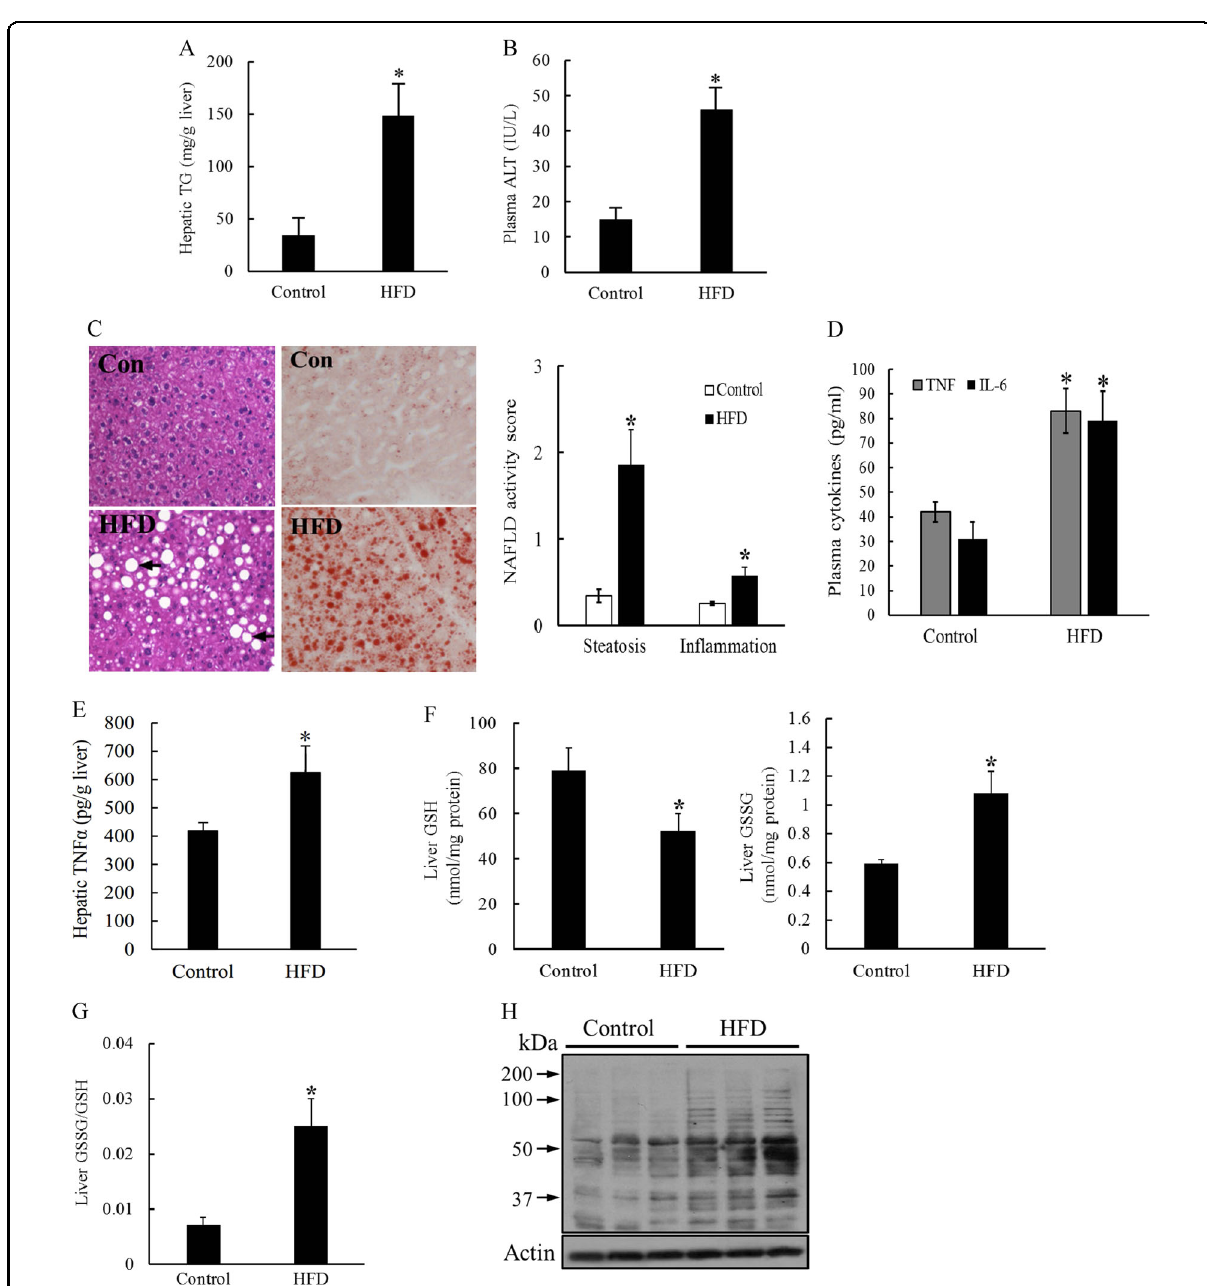
Fig. 1 NAFLD development is associated with increased TNF α production and dysregulated hepatic glutathione homeostasis. Male